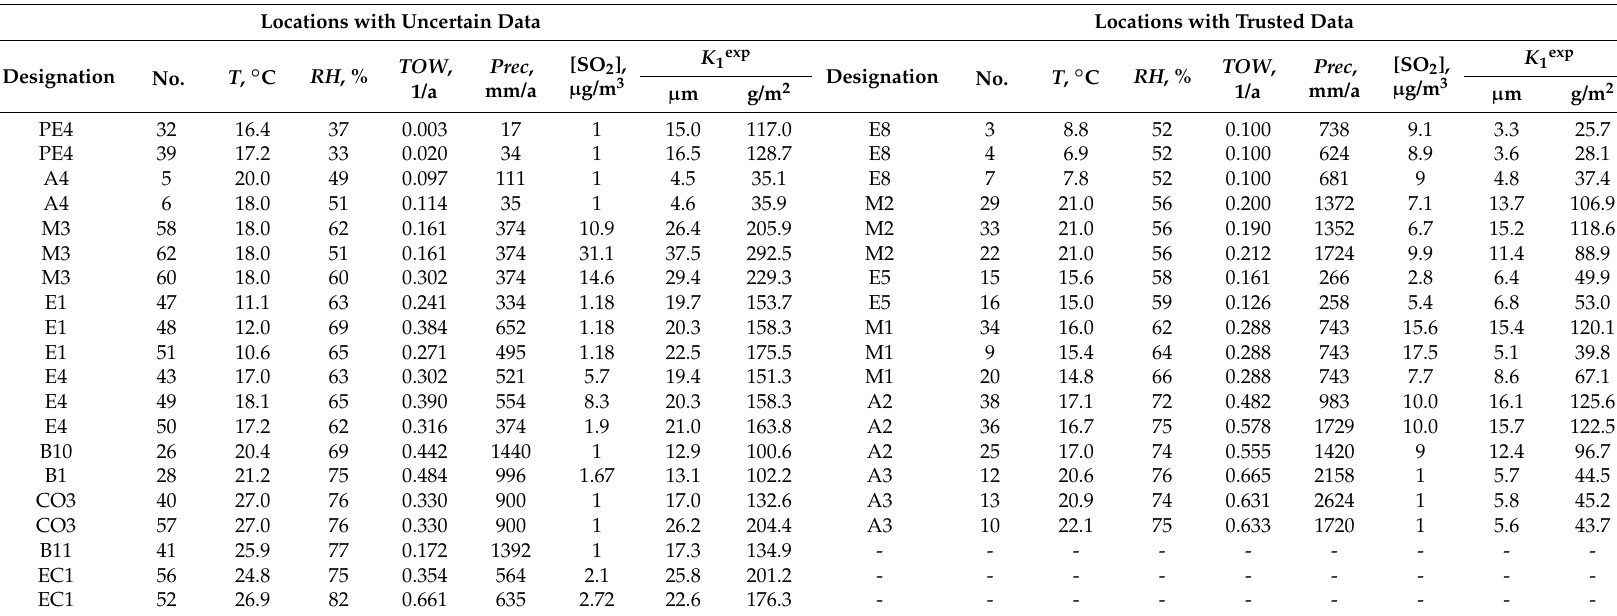
Table 6. Atmosphere corrosivity parameters and first year corrosion losses of carbon steel in certain test locations under the MICAT